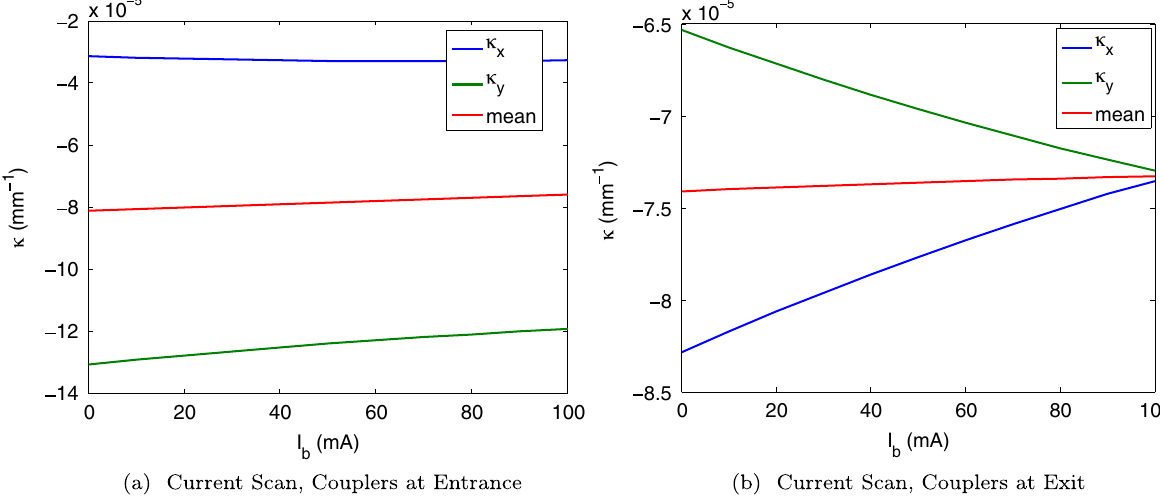
FIG. 12. Current scan from 0 to 100 mA for an initial beam energy of 350 keV and the couplers located at the entrance (a), and the couplers located at the exit